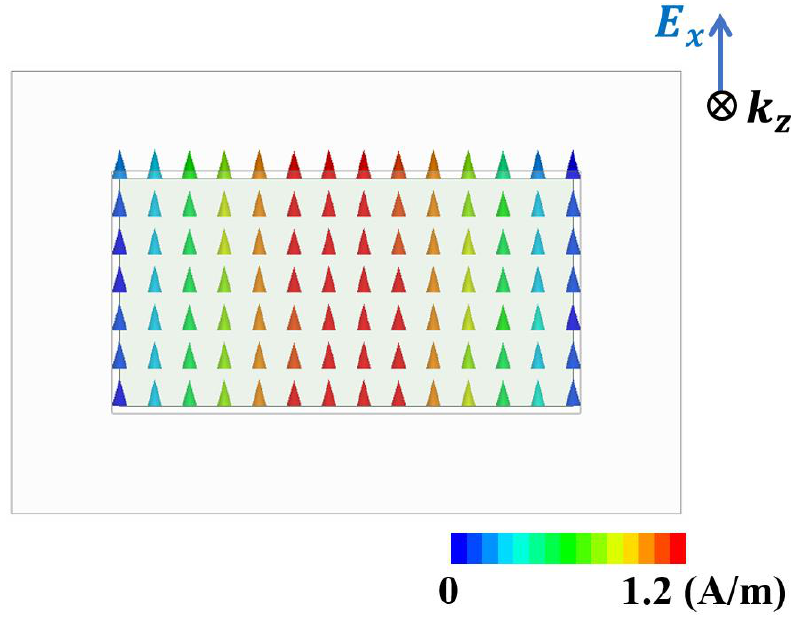
Figure 4. Simulated electric-field vector at the rectangular waveguide port.